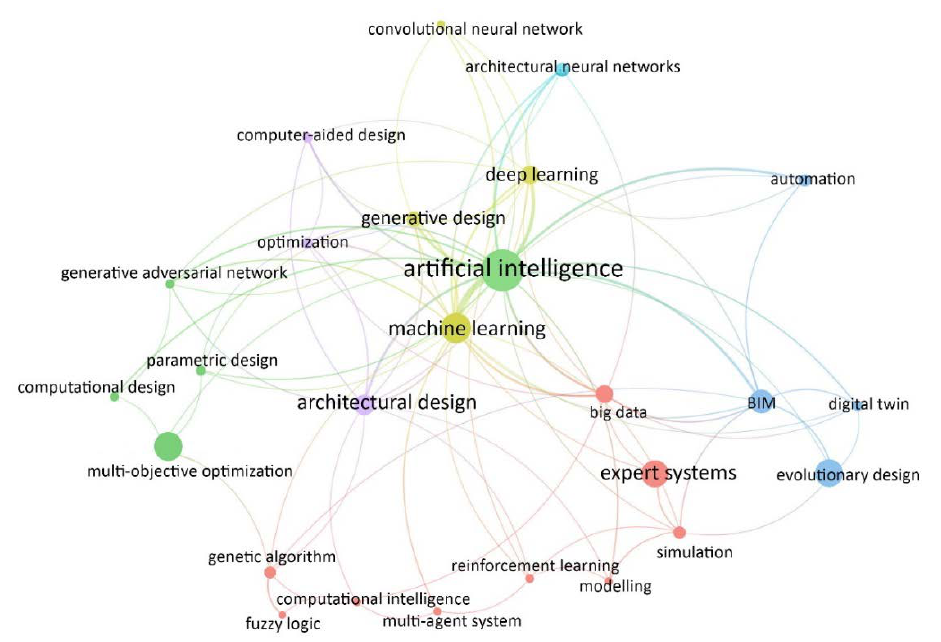
Figure 2 Keyword network analysis of the studies on artificial intelligence and architecture